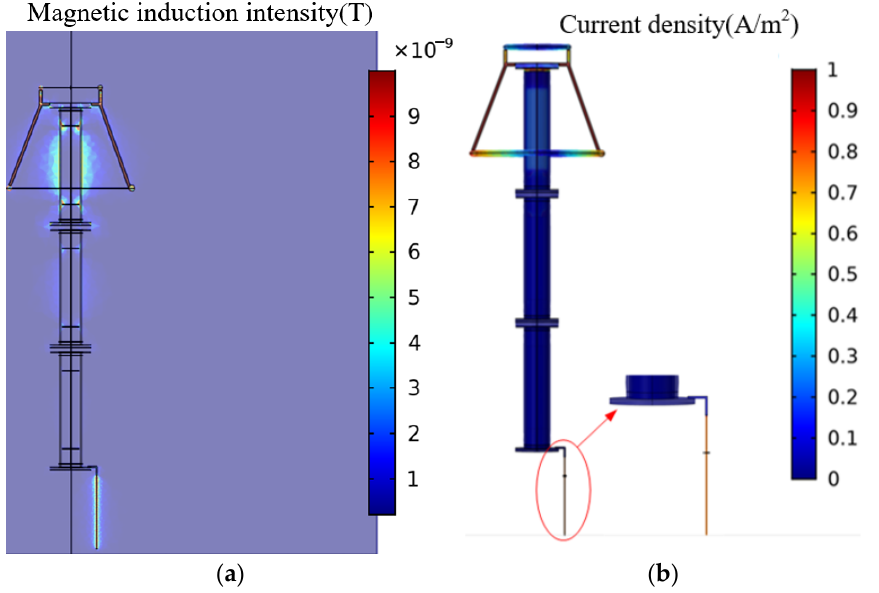
Figure 7. Electromagnetic characteristics of arresters. ( a ) magnetic field distribution; ( b ) current den-